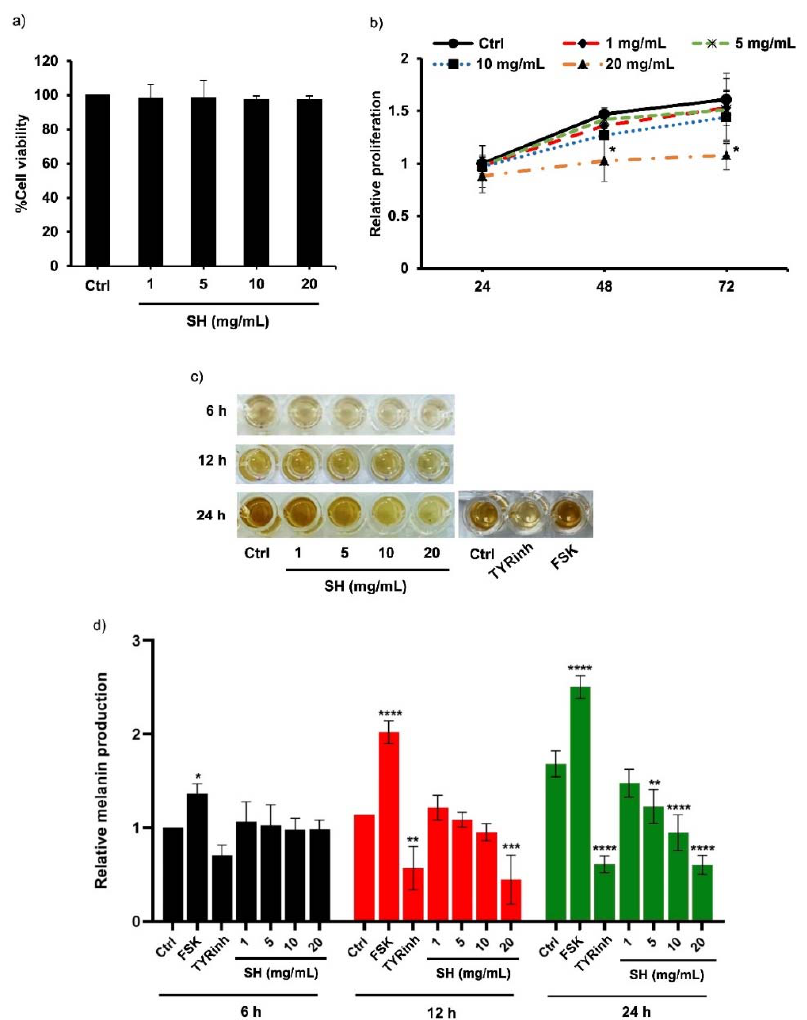
Figure 2. Inhibitory effect of Alcalase ® -hydrolyzed sericin on melanin production in human melanin-producing cells. ( a ) Despite no alteration of %cell viability detected via MTT assay after 24 h treatment with 1–20 mg/mL sericin hydrolysates (SH), ( b ) crystal violet assay indicated low proliferation in human MNT1 cells cultured with 20 mg/mL sericin hydrolysates for 48–72 h. ( c ) The melanin content was gradually increased in MNT1 cells after culturing for 6–24 h in the experiment condition. Notably, the remarkable decrease and increase of cellular melanin was respectively observed in MNT1 cells treated with 20 µ M tyrosinase inhibitor (TYRinh; 4-butylresorcinol) and 10 µ M forskolin (FSK) for 24 h. ( d ) Interestingly, sericin hydrolysates at 20 mg/mL significantly decreased melanin content in human melanin-producing cells promptly at 12 h treatment and sustainably until 24 h of the incubation time. Data are presented as means ± SEM from three independent experiments. * p < 0.05, ** p < 0.01, *** p < 0.005, **** p < 0.001 versus non-treated cells (Ctrl).